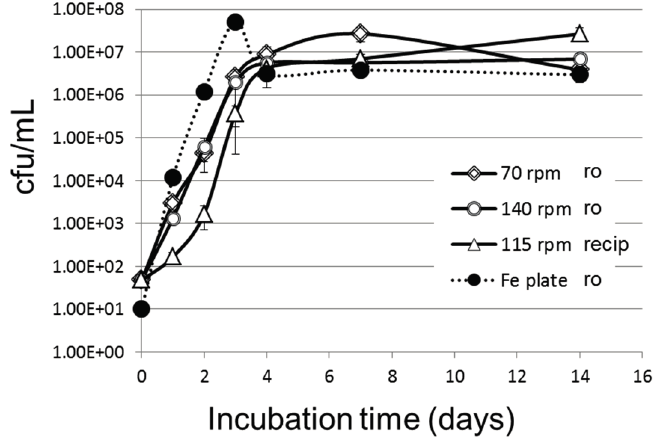
Figure 2. Time course of growth of cells of Leptothrix sp. strain OUMS1 cultured in SGP supplemented with 14 g/L of 150 μ m Fe powder under different shaking